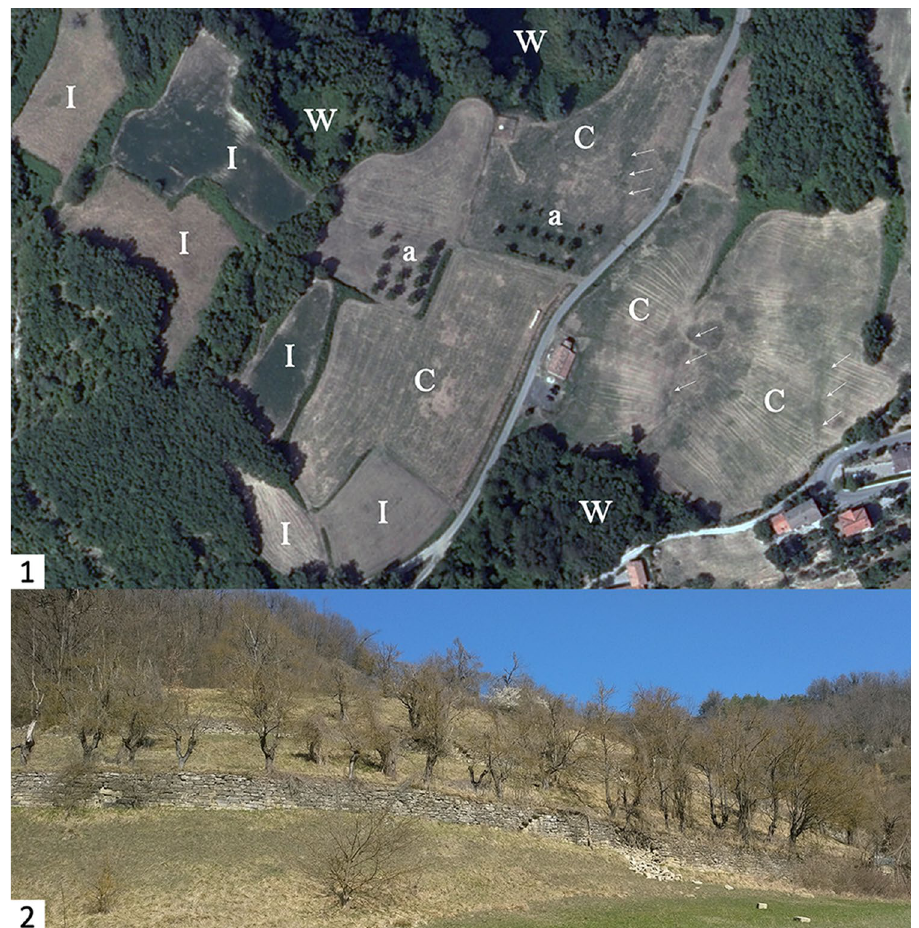
Figure 2. The most common historic landscape features in the study area. 1—irregular fields (I), combined fields (C), abandoned fields dominated by woodland (W), relics of agroforestry systems (a). The arrows